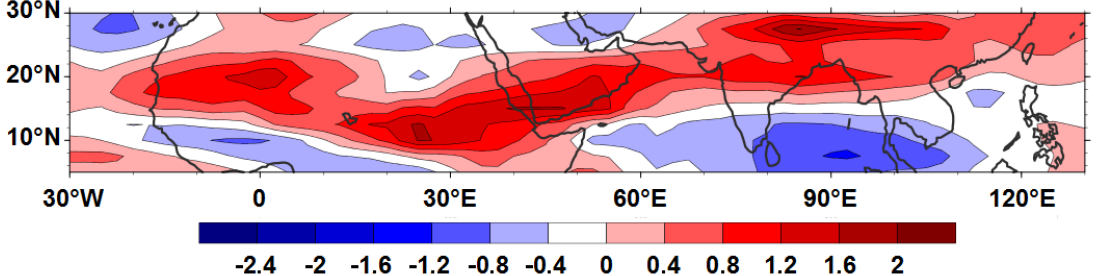
Figure 3. Climatology of the wind divergence (in day −1 ) from 500 to 300 hPa resulting from ECMWF ERA-Interim averaged from June to September over the period 1998–2008 between 0–30° N and 30° W–130° E.